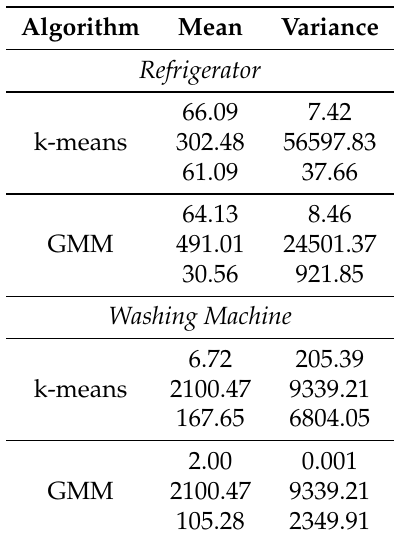
Table 5. Comparative results of k -means and Gaussian Mixture Model (GMM) clustering algorithm for extracting the power levels (mean and variance) of a refrigerator and a washing